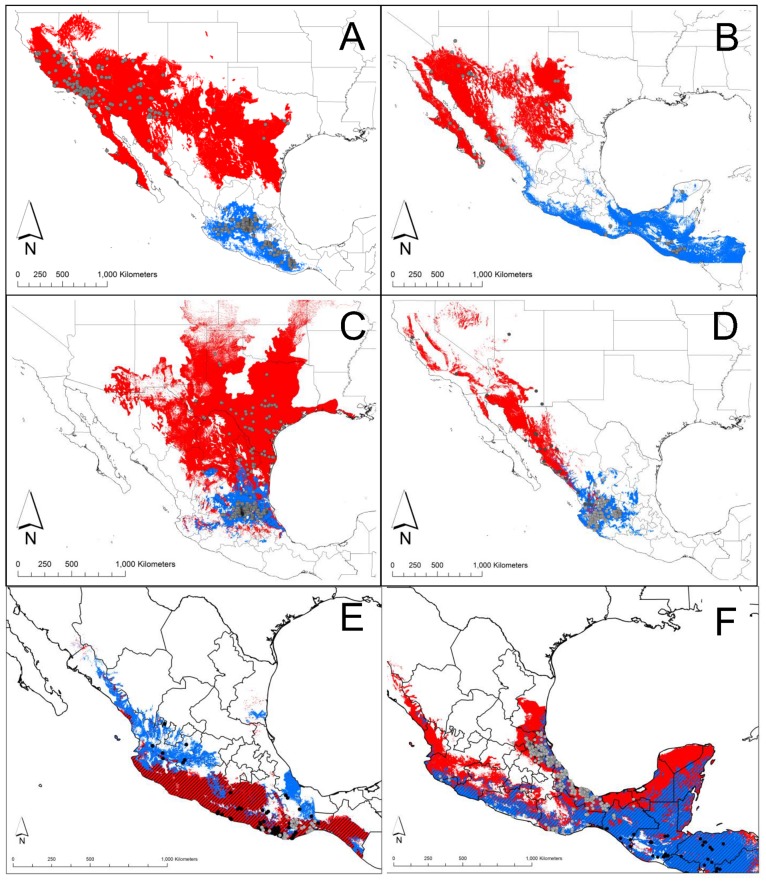
Ecological niche models for sister species pairs.A: Triatoma p. protracta (red) and T. barberi; B: T. rubida (red) and T. nitida (blue); C: T. gerstaeckeri (red) and T. mexicana (blue); D: T. recurva (red) and T. longipennis (blue); E: T. phyllosoma (red) and T. mazzottii (blue); F: T. dimidiata group 2 (red) and T. dimidiata group1a (blue). Grey dots and squares represent the collection sites for each species. Diagonal lines in E and F indicate the overlapping niche range between the sister pairs.